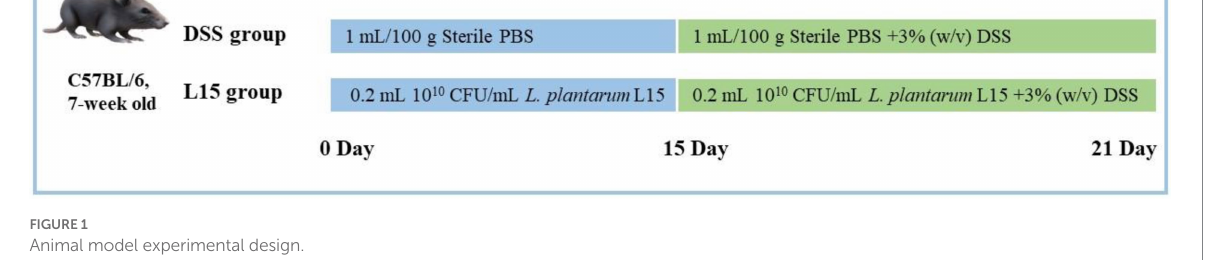
FIGURE 1 Animal model experimental design.